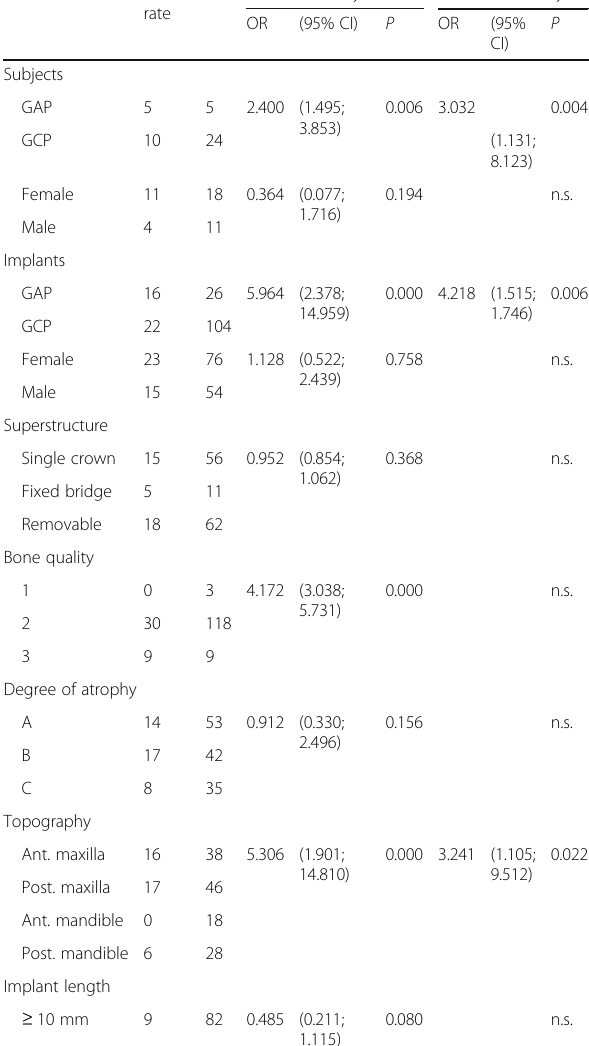
Table 5 Implant failure